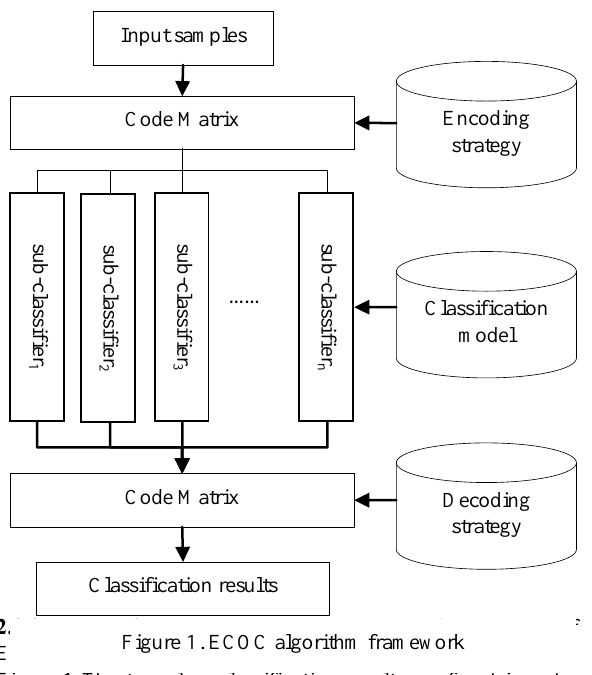
Figure 1. ECOC algorithm